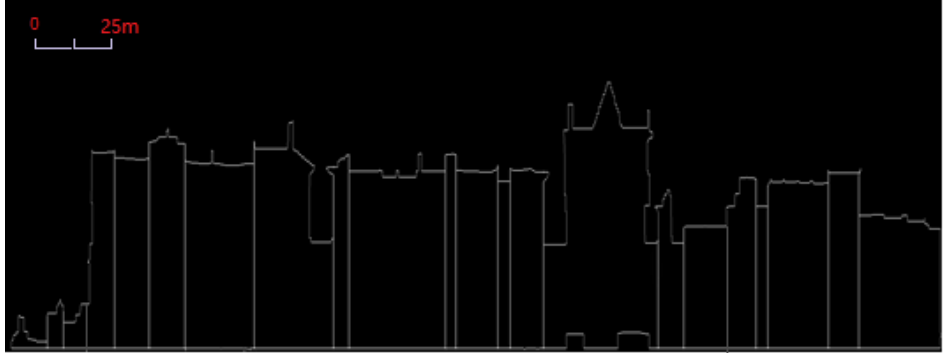
Figure 11. Sub-polygon segmentation result of building.